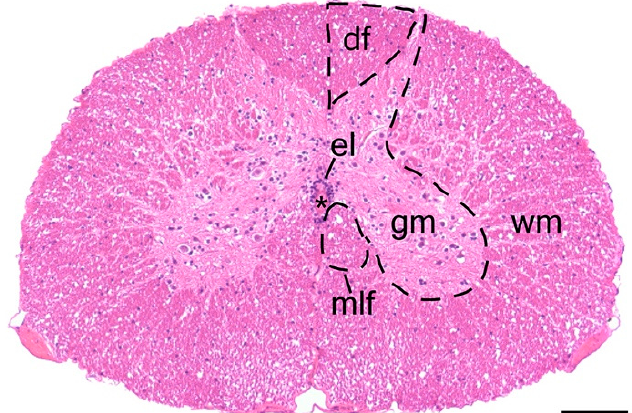
Figure 3. Histology of the gecko trunk spinal cord. A transverse section of the trunk spinal cord stained with hematoxylin and eosin. The spinal cord shows a butterfly-shaped grey matter sur- rounded by columns of white matter. The dorsal horns of the grey matter divide the white matter into paired dorsal funiculi. The ependymal layer is centrally located in the spinal cord and lines the central canal. Ventral and medial to the ependymal layer are the paired medial longitudinal fasciculi. * = central canal, df = dorsal funiculus, el = ependymal layer, gm = grey matter, mlf = medial longitudinal fasciculus, wm = white matter. Scale bar = 100 µm.